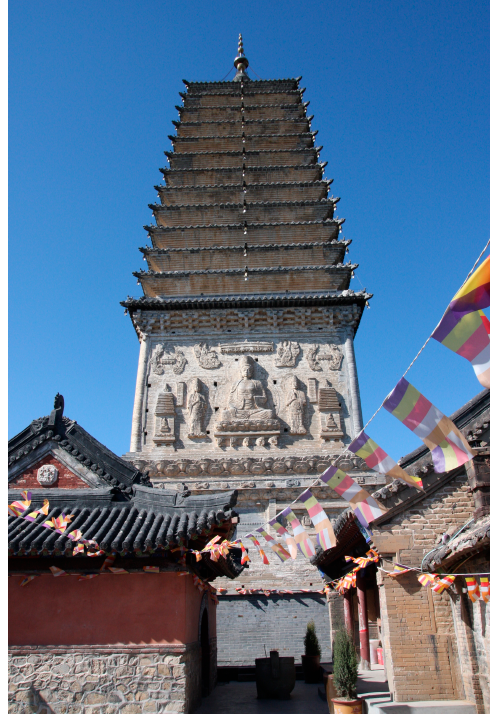
Figure 13. Yunjiesi Pagoda (also called the Moyun Pagoda), Mt. Fenghuang in Chaoyang, Liaoning Province, China. Liao dynasty [©Photograph by Youn-mi Kim, 2007].